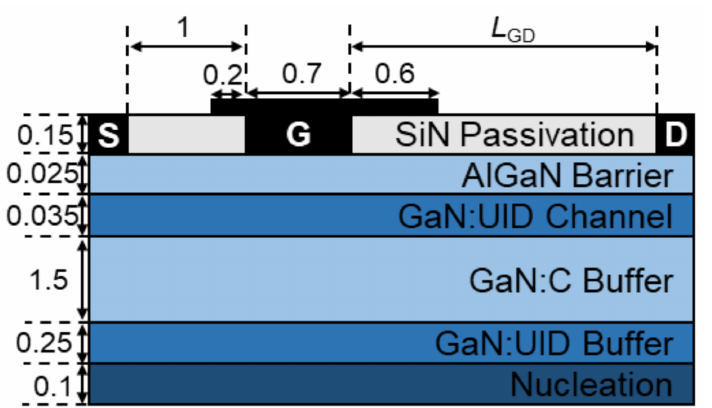
Figure 1. Cross-section of the simulated Schottky-gate HEMT resembling the C-doped device in [1]. Dimensions are in µ m (not to